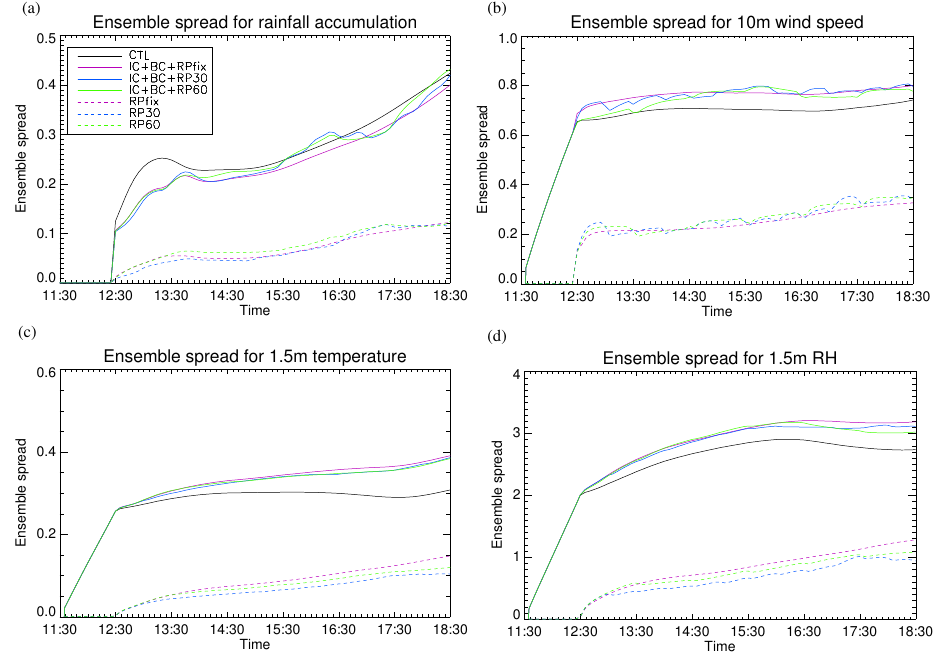
Fig. 14. Evolution of ensemble spread with forecast time for the different ensembles, for (a) hourly rainfall accumulation (mm), (b) 10m wind speed (ms − 1 ), (c) 1.5m temperature (K) and (d) 1.5mRH